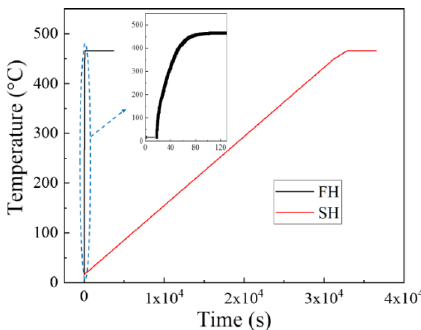
Figure 1. The measured heating curves for both FH and SH samples.